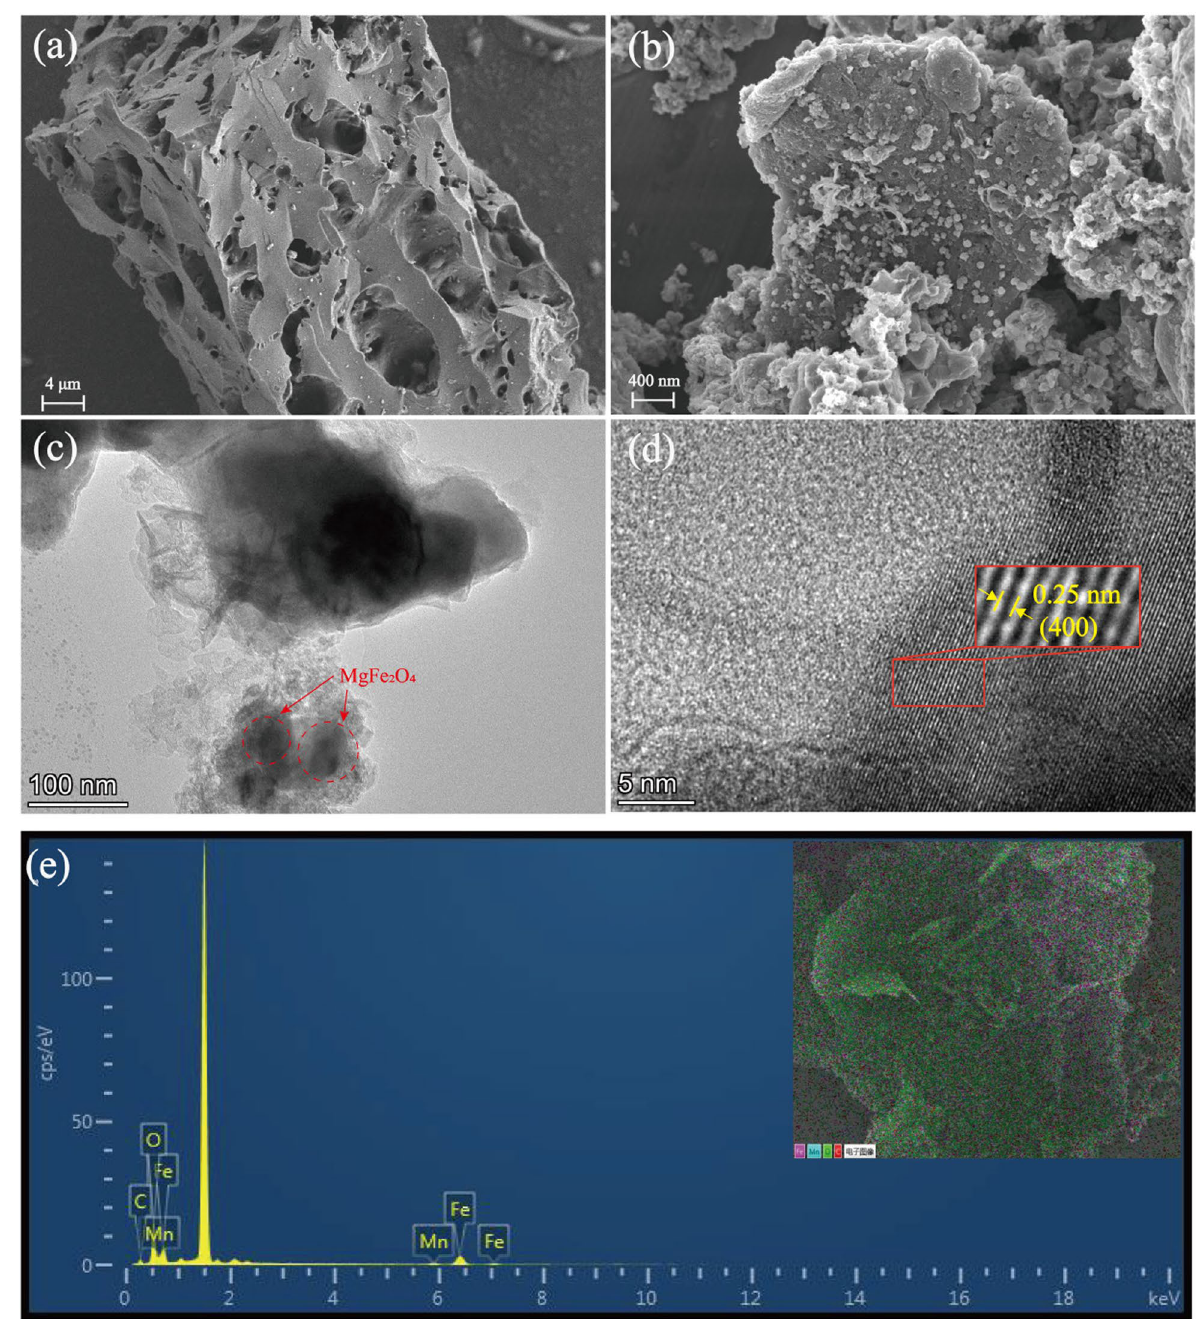
Fig. 1 SEM images of BC ( a ) and MFB ( b ), TEM ( c ) and high-resolution TEM (HR-TEM) images of MFB ( d ), EDS spectrum and elemental mappings of MFB ( e